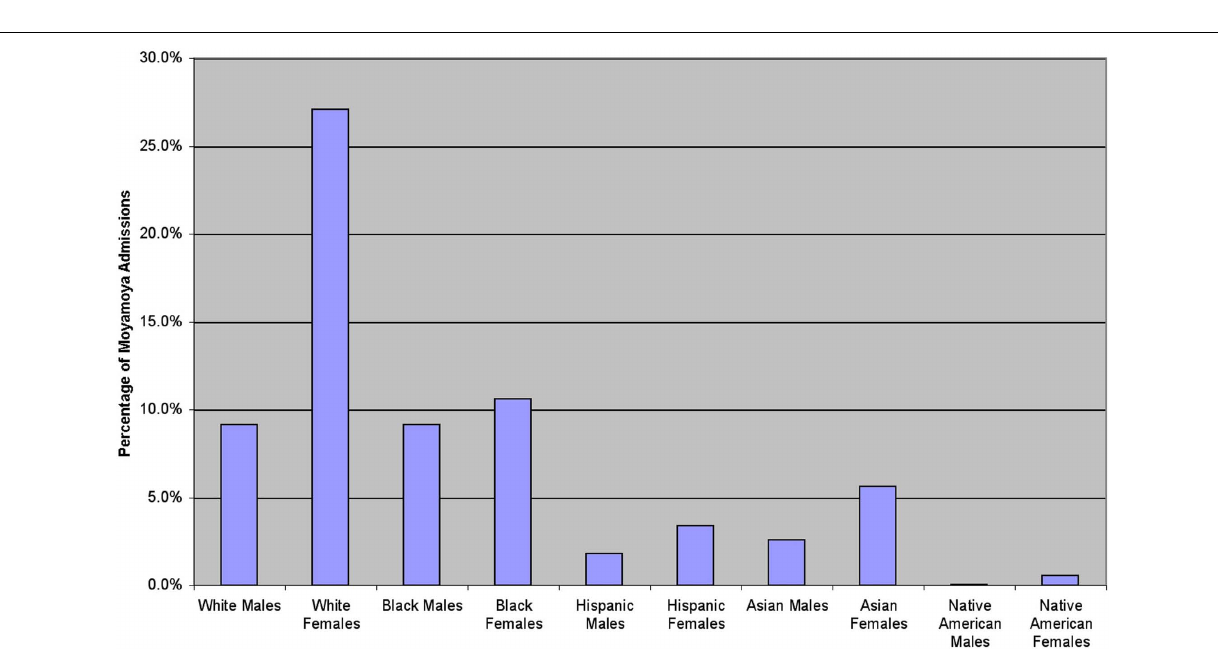
The incidence of cerebral angiography varied over time, ranging from 13.9 to 47.1%; however, there was no particular trend in the incidence of this